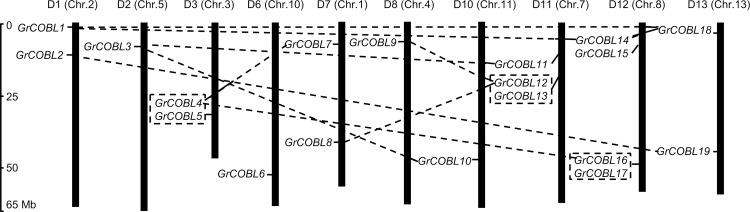
Chromosomal distribution of the COBL family genes in G. raimondii.The chromosome numbers were consistent with the interspecific genetic map (D1 to D13) in allotetraploid cultivated cotton species [34] and the scaffolds (Chr.1 to Chr.13) in the genomic data of G. raimondii [30]. The nomenclature of COBLs was based on the order of the chromosomes in G. raimondii. Lines were drawn to connect the duplicated genes.